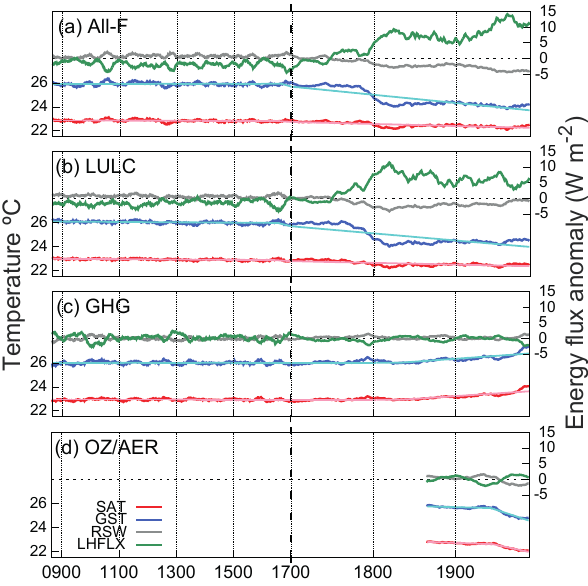
Figure 12. The same as in Fig. 11 but for a grid point located at 12 ◦ S, 40 ◦ W in northeast Brazil. LHFLX is also represented instead of SHFLX.